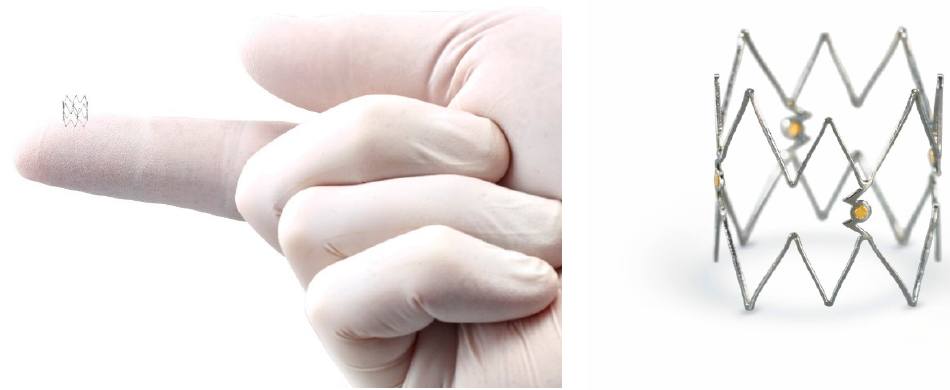
Figure 9. BTK Tack Endovascular System. Courtesy of Intact Vascular Inc.